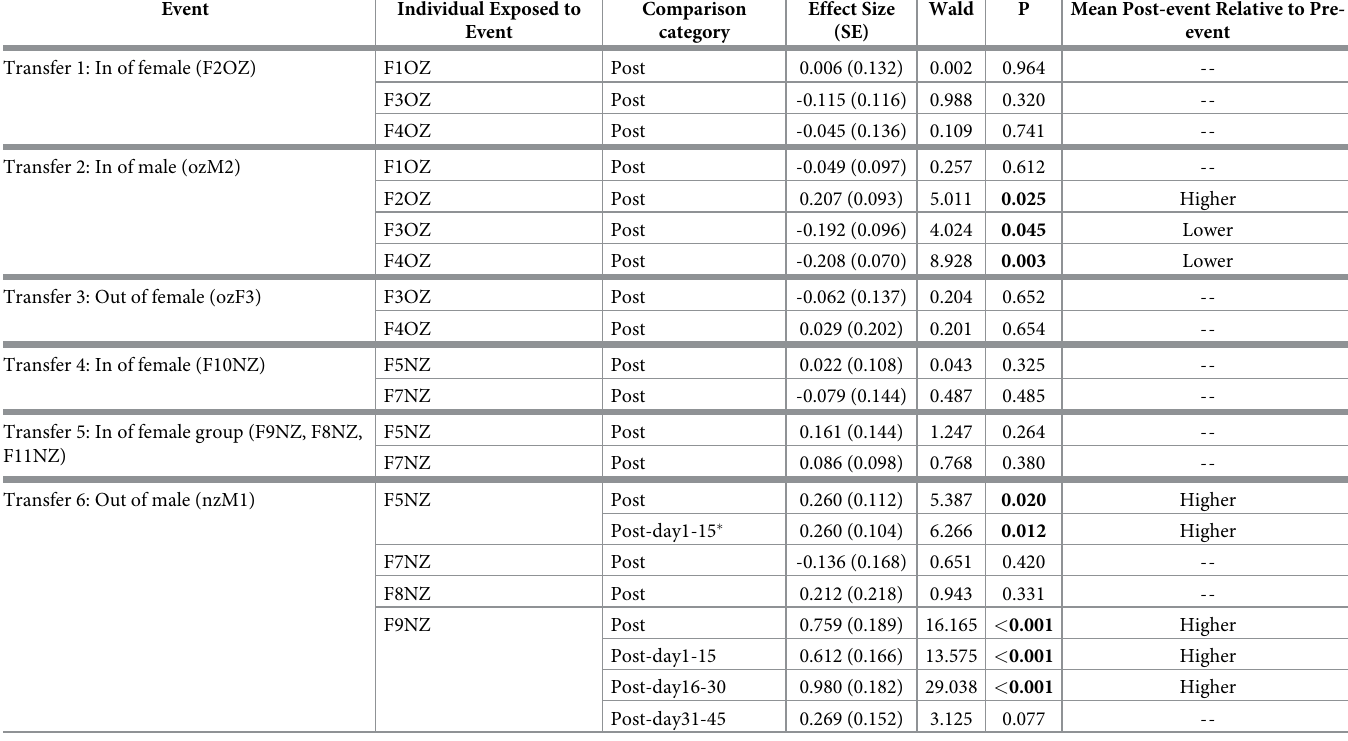
Table 6. Transfer of a herdmate as a predictor of adrenal GC activity. Fixed effects, effect size with standard error (SE), Wald statistic, and p-value from GLMMs, and whether the mean cortisol concentration post-event was higher or lower than pre-event. Degrees of freedom (df) was 1 in all pair-wise